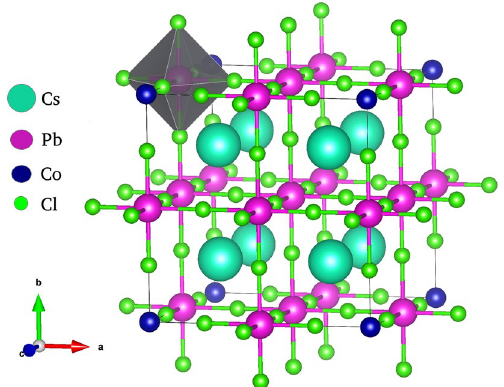
Figure 1. Possible crystal structure of 15% Co- doped tetragonal CsPbCl 3 halide